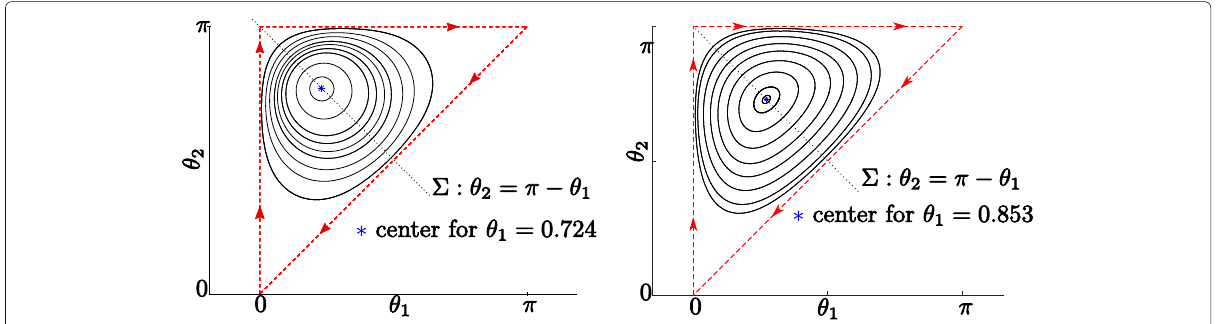
Fig. 13 One parameter family of geodesic strokes for the Euclidean metric (left) and for the mechanical cost